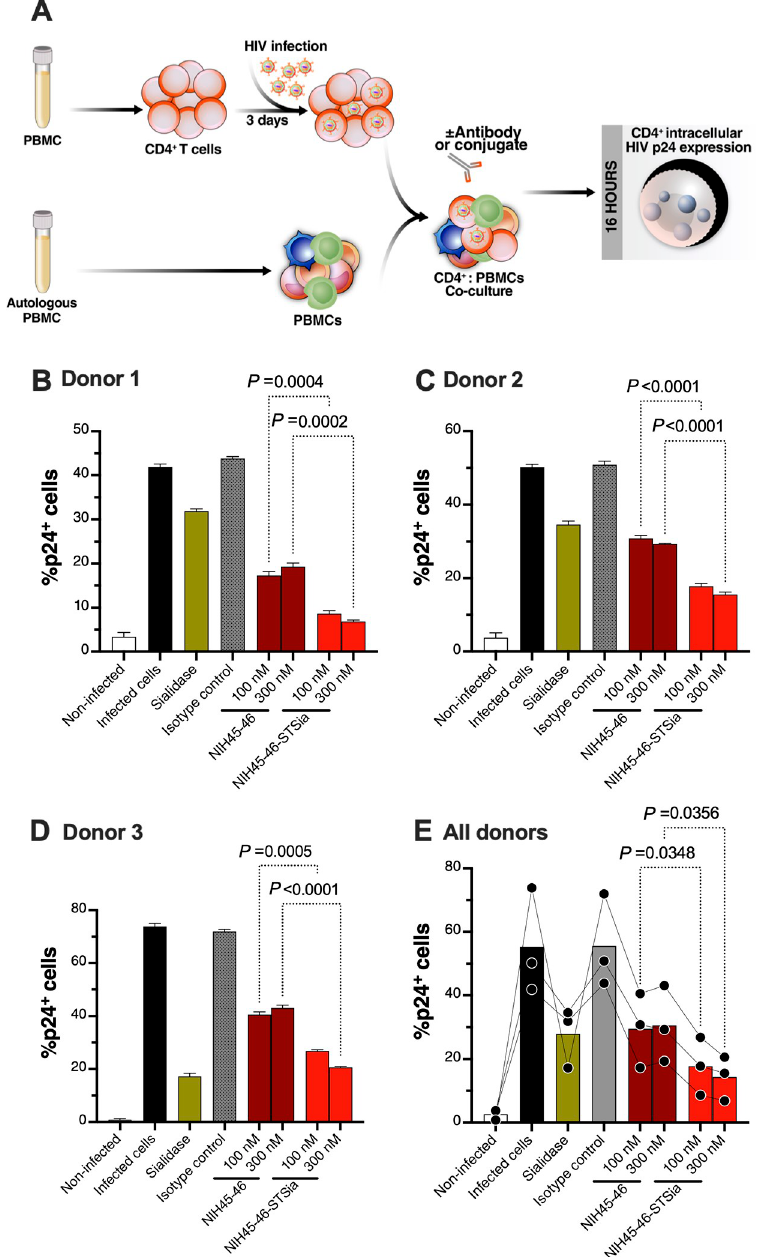
Fig 9. NIH45-46-STSia induces PBMC cytotoxicity towards autologous primary HIV-infected CD4 + T cells. (A) A schematic representation of the workflow to evaluate the cytotoxicity of PBMC against autologous HIV-infected CD4 + T cells in the presence of bNAb or bNAb-STSia conjugate. CD4 + T cells were isolated from fresh PBMC and exposed to HIV-1 IIIB for 72 h. On the third day, virus-infected CD4 + T cells were treated or not with Sialidase, NIH45-46, NIH45-46-STSia, or isotype-matched control antibody. PBMC from the same donor were co-cultured with autologous HIV-infected CD4 + T cells for 16 h. Following overnight incubation, the mixtures were stained for live/dead viability, CD3, CD8, and intracellular p24. Percent p24 + was derived after gating on CD3 + , CD8 - and live cells. (B) Data from donor 1. (C) Data from donor 2. (D) Data from donor 3. (E) Average data from all donors. Assay from each donor was performed in 4 replicate wells (E:T 100:1; n = 3 donors). Statistical analyses for panels B-D were performed using unpaired ANOVA with post-hoc Dunnett T3 method (to correct for multiple comparisons) comparing the indicated groups. Statistical analysis for panel E was performed using paired ANOVA with post-hoc Holm-Sidak method (comparing the indicated conditions).